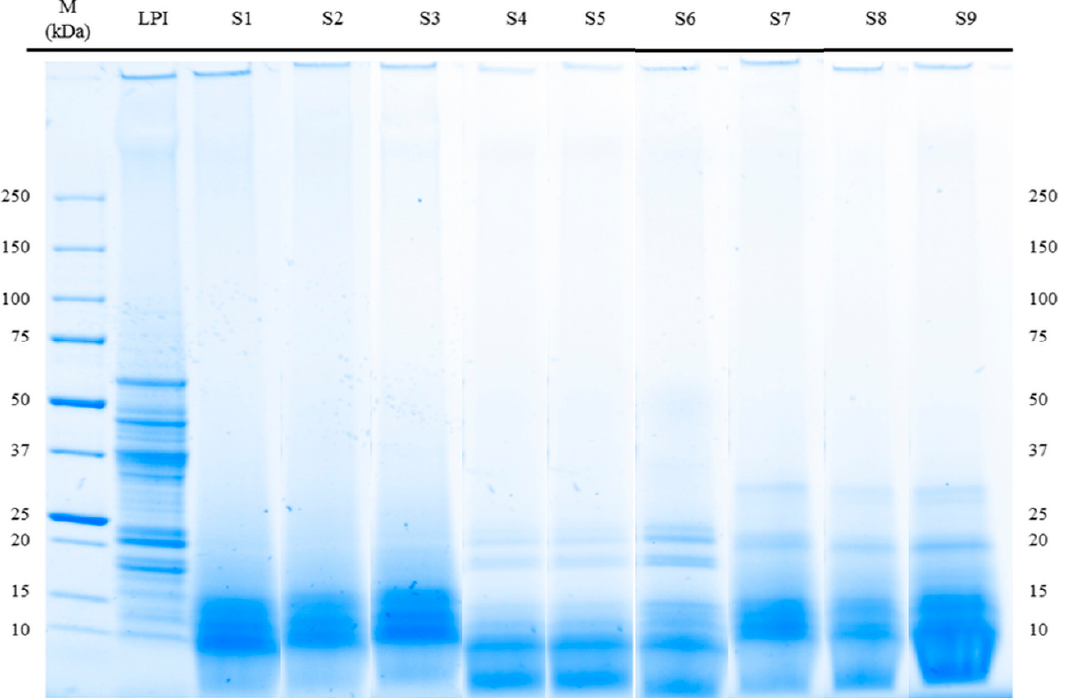
Figure 2. Peptide band profiles of LPI and fermented LPI hydrolysates as determined by SDS-PAGE under reducing con- ditions.